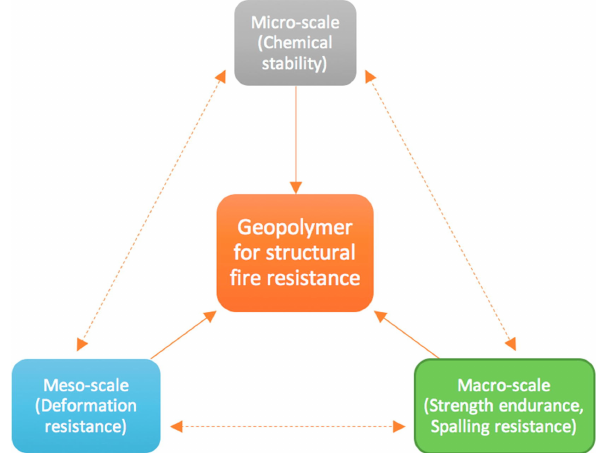
Figure 6: Methodology to ensure good structural performance of geopolymers subject to high temperature heating